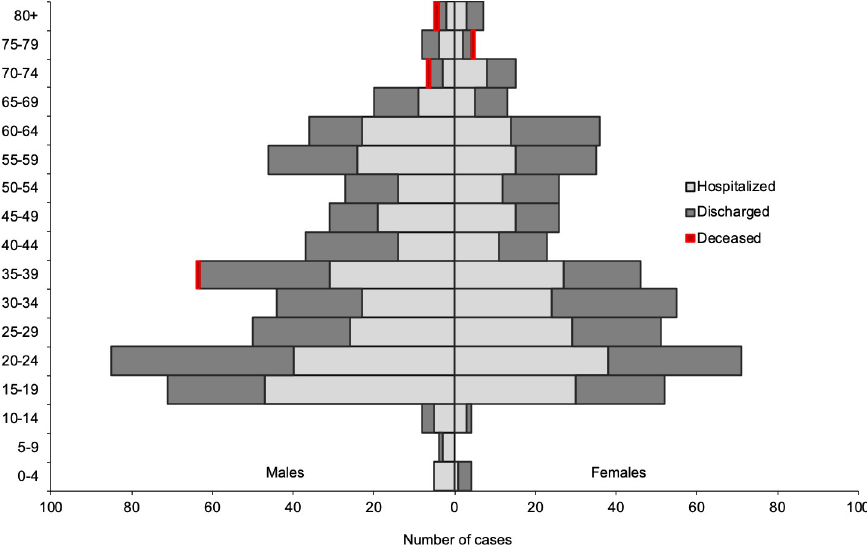
Fig 1. Age and sex distribution of confirmed COVID-19 cases Hong Kong (n = 1,017, as of April 16, 2020). Data Source: Hong Kong Center for Health Protection, Department of Health.